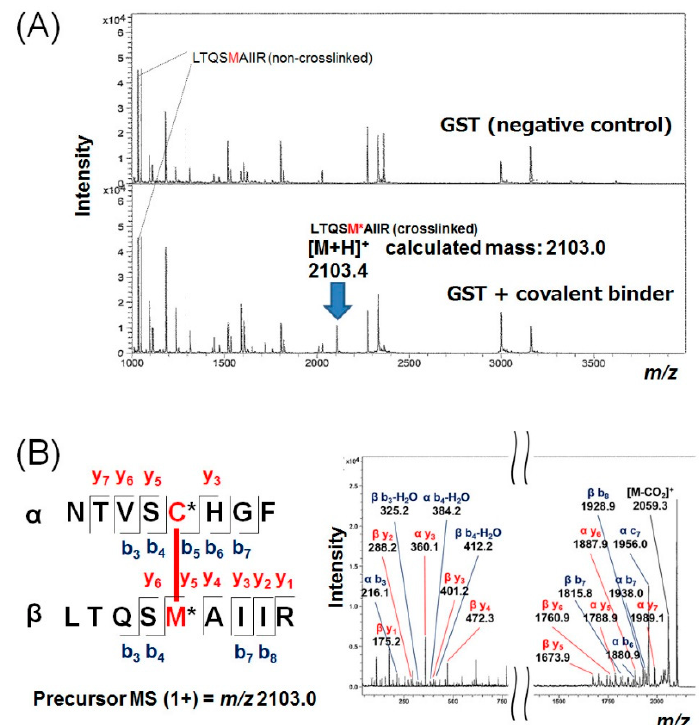
Figure 4. ( A ) Identification of trypsinized peptide fragments derived from the covalent-binder-conjugated GST by MALDI-TOF-MS analysis (lower panel). As a negative control, pristine GST was also trypsinized, and the resulting fragments were also analyzed under the same conditions (upper panel). A newly appeared fragment in the presence of the covalent binder is highlighted by a blue arrow. ( B ) MS/MS spectra of the newly appeared fragment. All the detected fragments were consistent with theoretical m / z values of the represented structure; b- and y-ions are highlighted by using blue and red colors, respectively. The peptide fragment of LTQSMAIIR was derived from a constituent of the glutathione binding pocket of GST protein; judging from the peak intensity of the remaining non-crosslinked fragment (lower panel in A), the crosslinking reaction yield was estimated to be a few percent. M* and C* mean conjugated methionine and cysteine, respectively; the conjugation is highlighted by a thick red line.